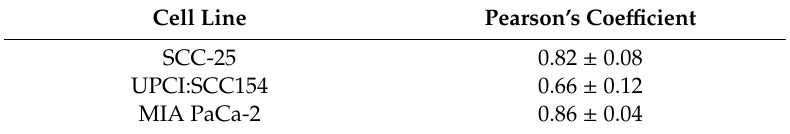
Table 2. Pearson’s correlation coe ffi cient of the colocalization between dNAs and lysosomes.